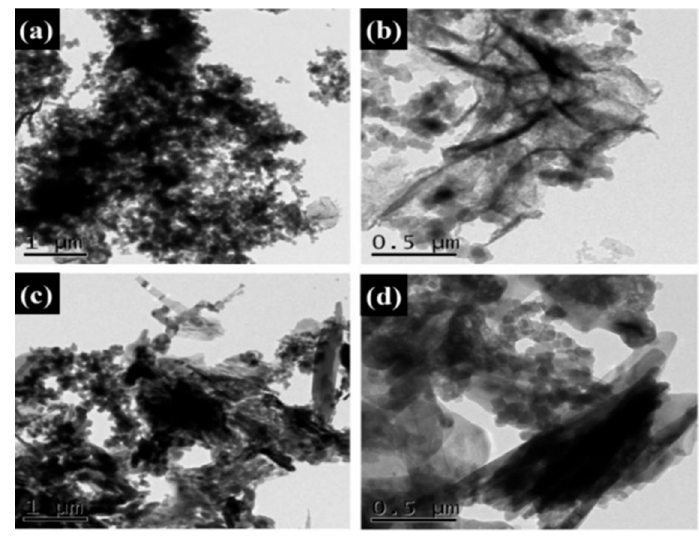
Figure 8. Transmission electron microscopy (TEM) images of ( a , b ) GO–SiO 2 (GS-3) and ( c , d ) GS-PCMs-3.